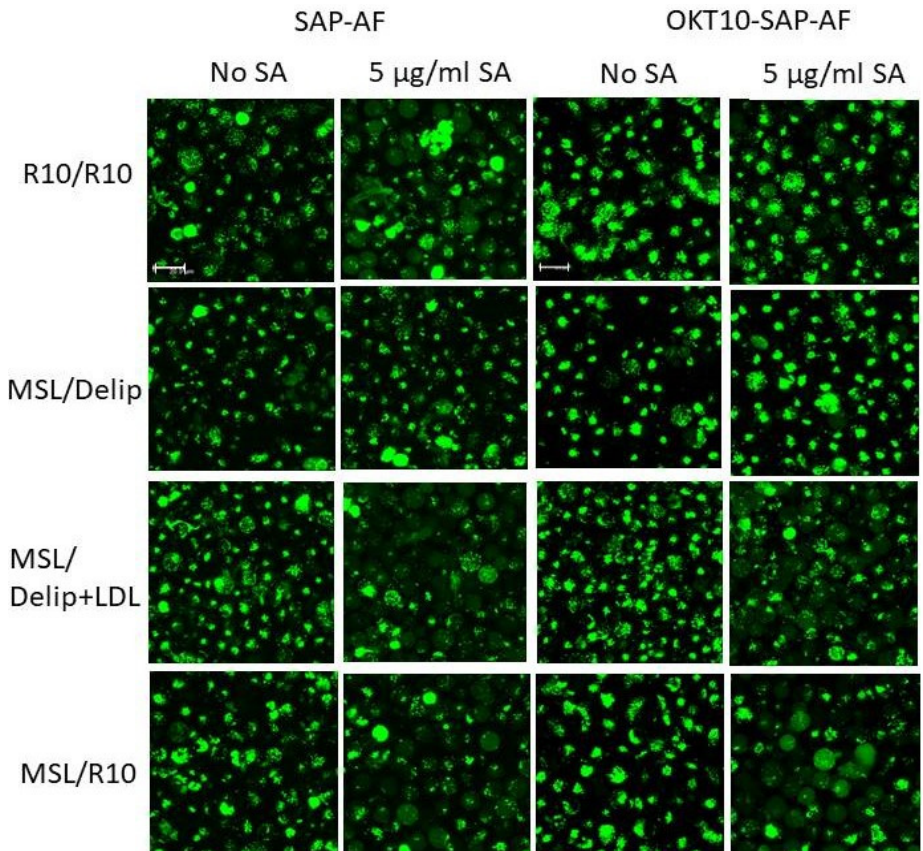
Figure 5. Fluorescence confocal microscopy images of mock-treated Daudi control cells, lipid deprived cells and lipid deprived cells repleted with LDL or R10 for 24 h including incubation with OKT10-SAP-AF (green) or SAP-AF (green) for 20 h prior to exposure to 5 µg/mL SA for 24 h. The images presented are the maximum projections of a series of 21 z-slices at 1 µm spacing. The scale bar represents 20 µm.